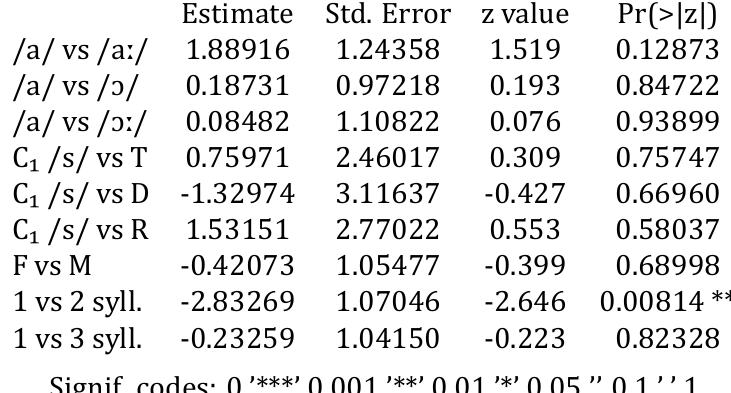
Table A.21: Breathiness duration (ms) prior to C₂ fortis plosive as a dependent